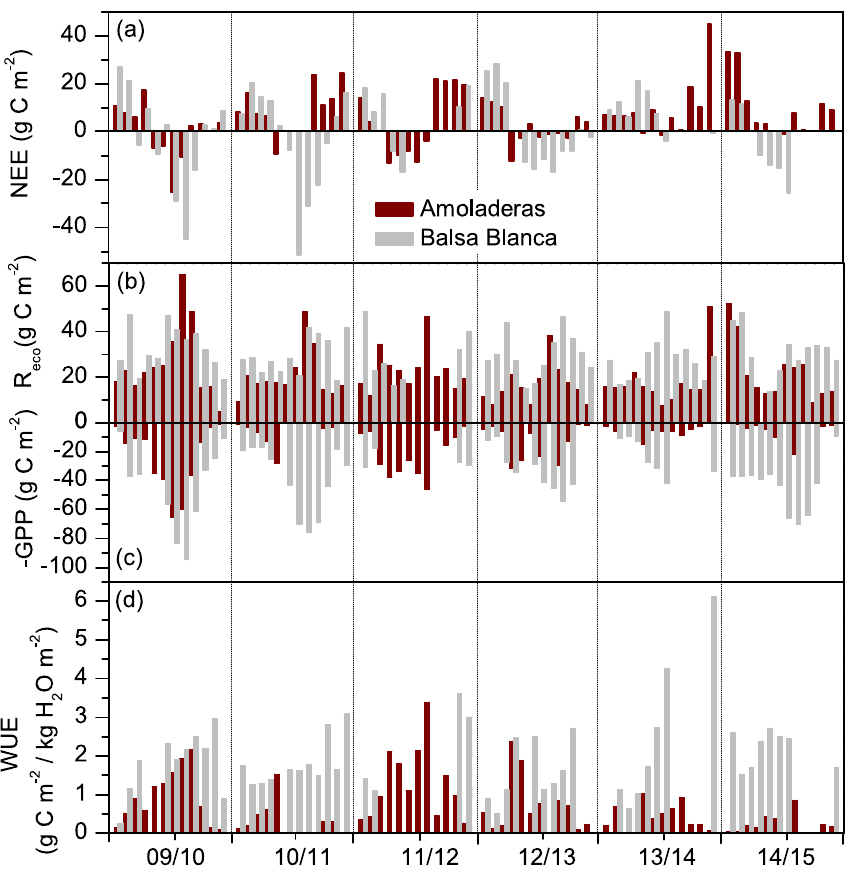
Figure 7. Monthly cumulative fluxes of (a) biological net ecosystem CO 2 exchange, (b) ecosystem respiration ( R eco ), (c) negative gross primary production and (d) water use efficiency over the 6 hydrological years of study (2009–2015) for Amoladeras (dark red) and Balsa Blanca (grey). Missing bars correspond to long-term data losses. Table 5. Results of the two-sided Wilcoxon summed rank test used to assess differences among meteorological variables measured at each experimental site over all periods, from May to September and from May to September during daytime, separately. Medians of the difference between the samples (Amoladeras minus Balsa Blanca) in standardized terms (Diff st ) and number of observations are detailed. Significant results ( p -value < 0.05) are denoted with asterisks, and bold values represent those variables with Diff st between sites above 1. Variables All